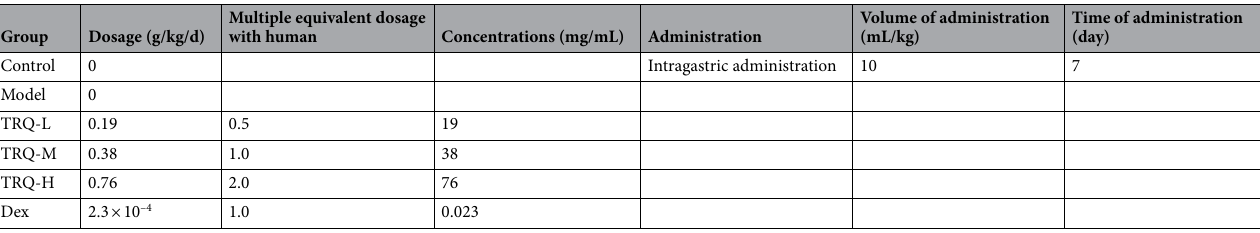
Table 1. The information of